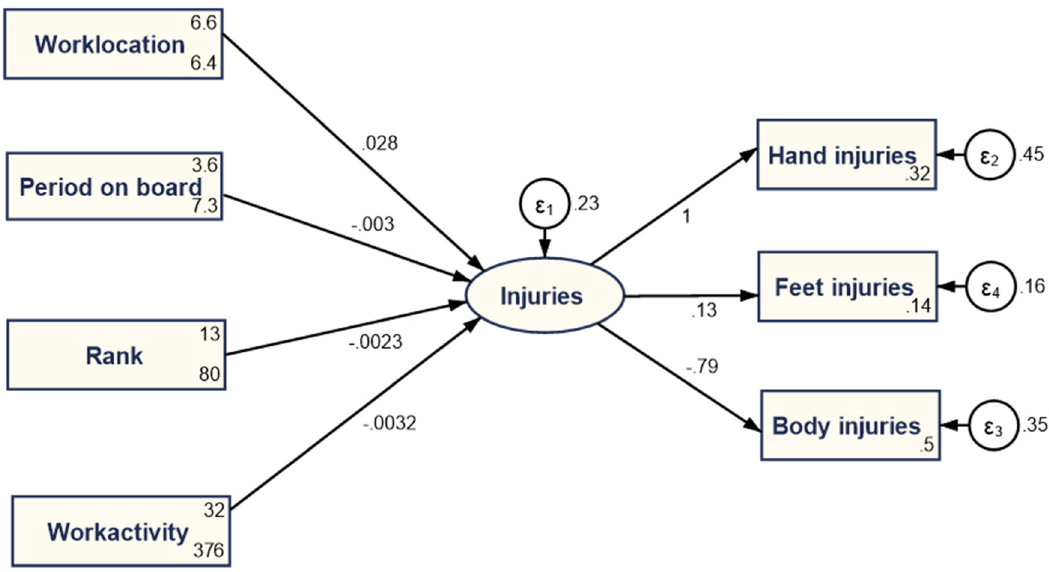
Figure 5. SEM 1, first model of structural equation modeling. Table 4. Detailed results of SEM 1—first model of structural equation